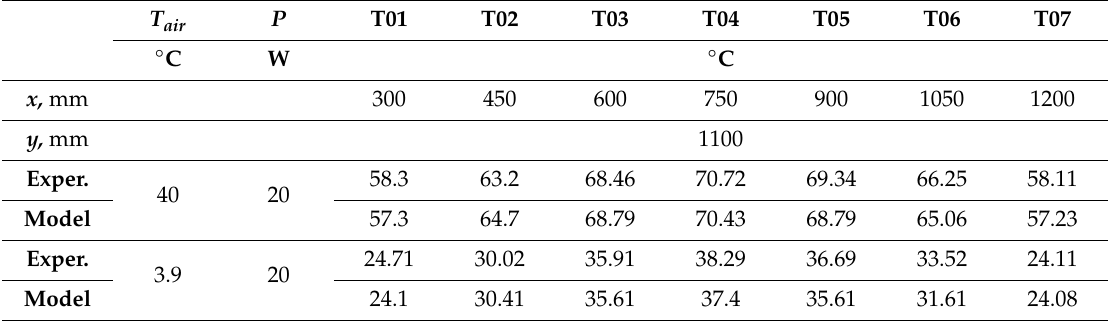
Table 2. Temperature values obtained from tests and simulations (temperature values around heaters 1 and 2).